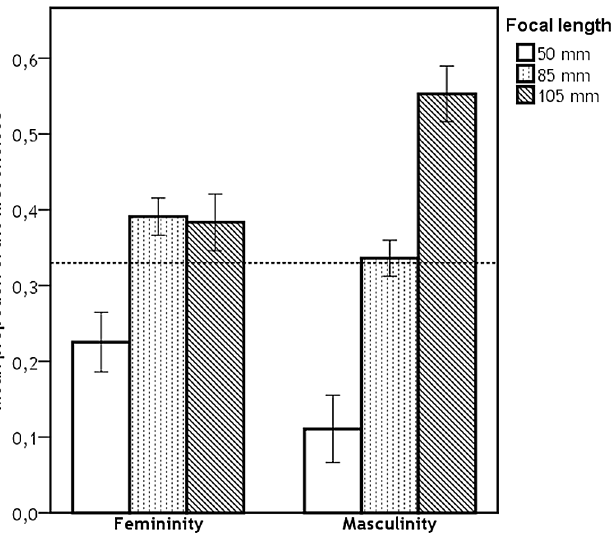
Fig 4. Proportion of first choices for each focal length with respect to their femininity/masculinity. Dashed line represents the proportion of ratings expected by chance (i.e., 0.333), error bars represent 95% CI.